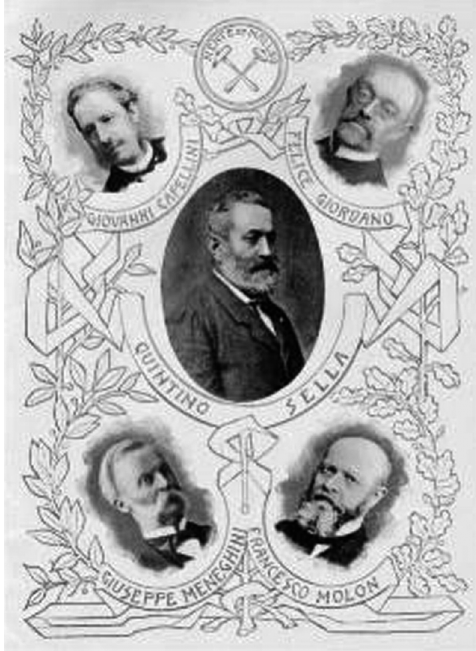
Fig. 2. Image taken from the Volume 1 S.G.I. Bul- letin (1882) depicting the Perpetual Partners of the Italian Geological Society. From left up to right down G. Capellini, F. Giordano, Q. Sella, G. Meneghini and F. Molon (from